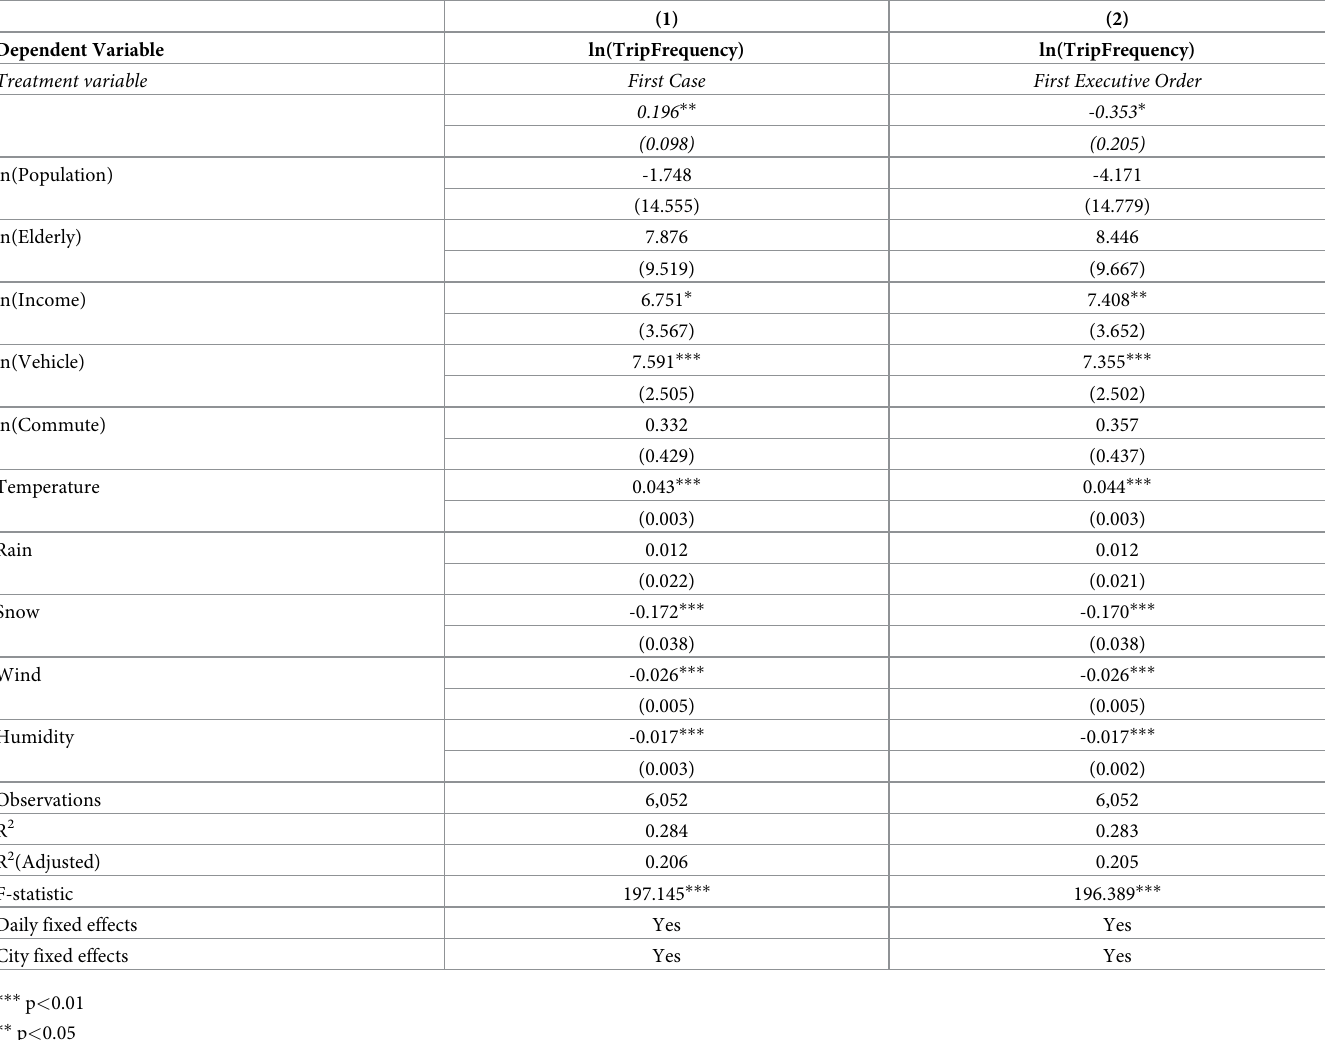
Table 4. Bike-sharing trip frequency: Fixed-effects regression